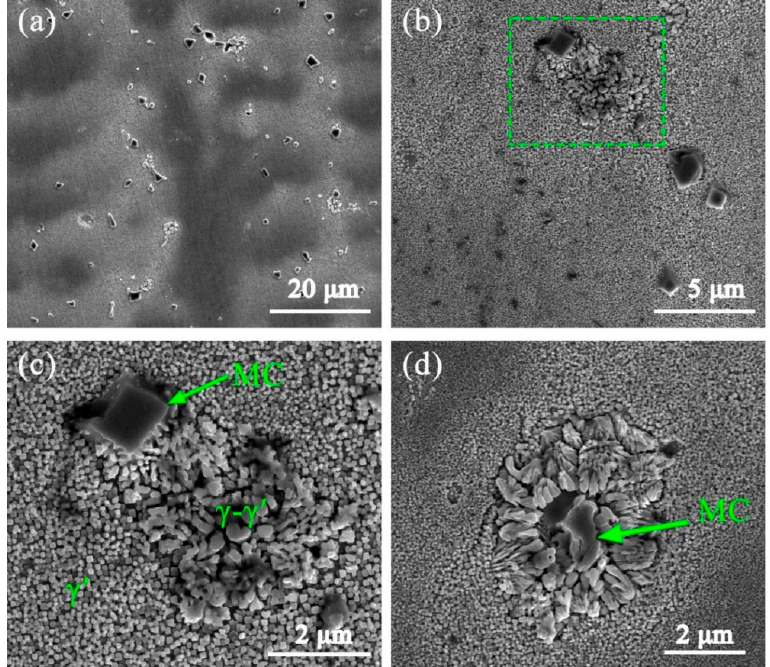
Figure 8. SEM micrograph of the AF sample, containing ( a ) macro morphology of precipitates, ( b ) microstructure at high magnification, ( c ) high-resolution image of the green rectangle region, and ( d ) another morphology of eutectic precipitates with MC carbides in the central point.